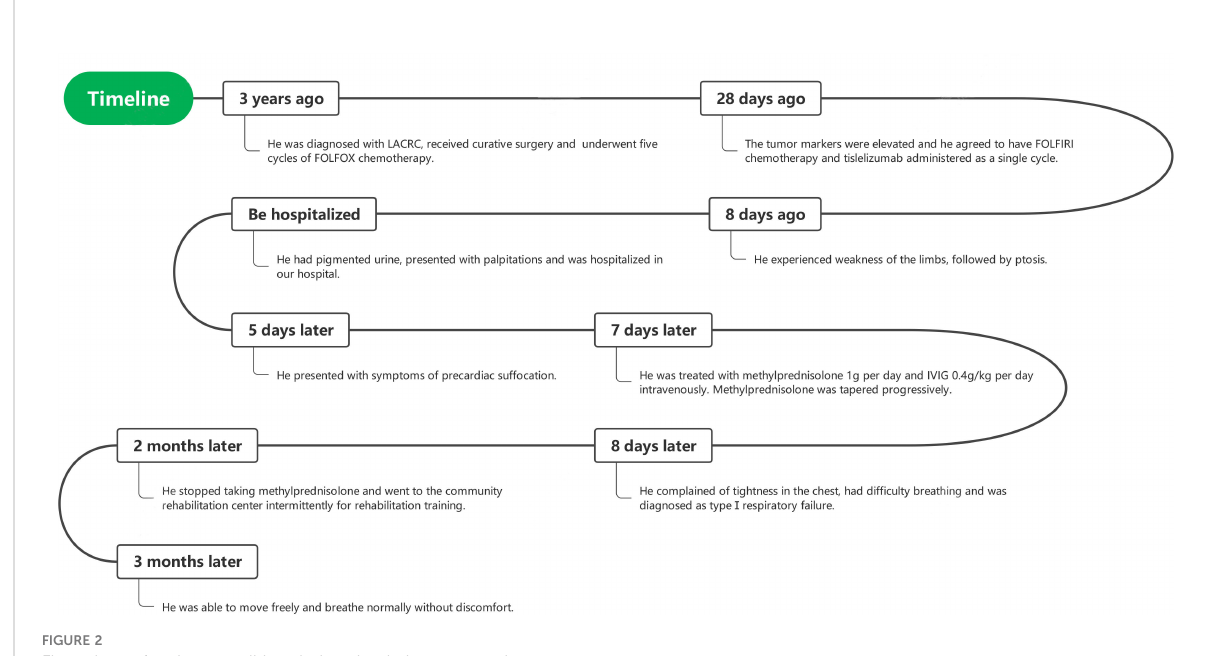
FIGURE 2 Flow chart of patient condition during simulation